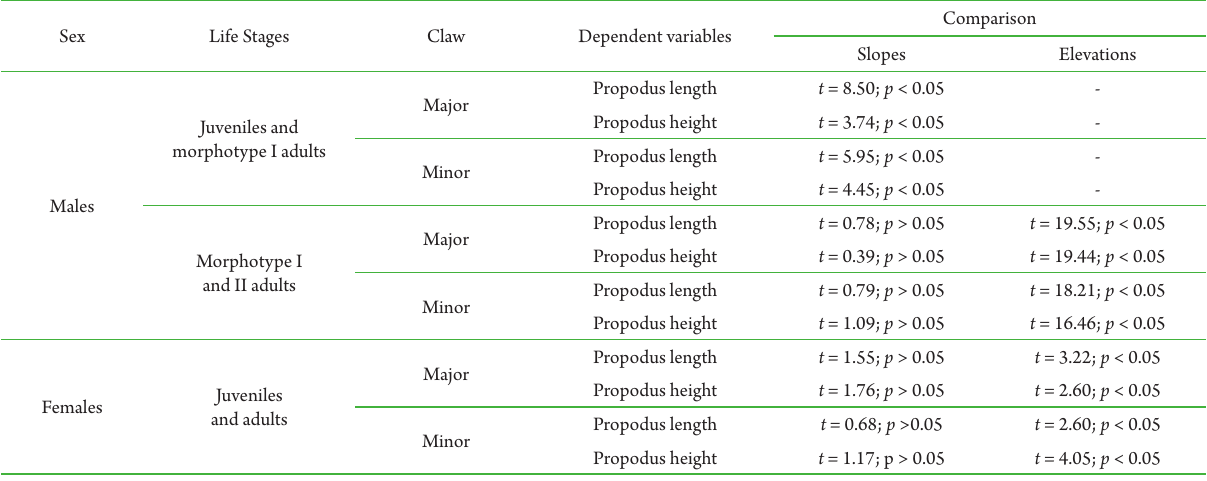
Table 2. Comparison of linear regression parameters between life stages of Aegla castro .